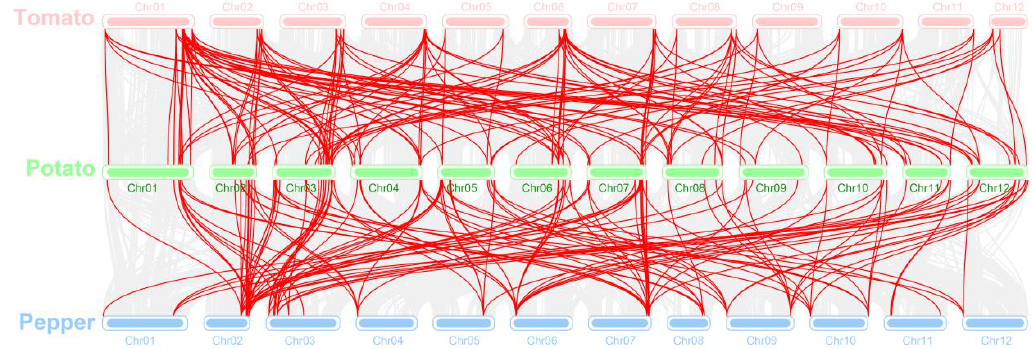
Figure 6. Synteny blocks of MAPK and MAPKK genes among potato, tomato and pepper.